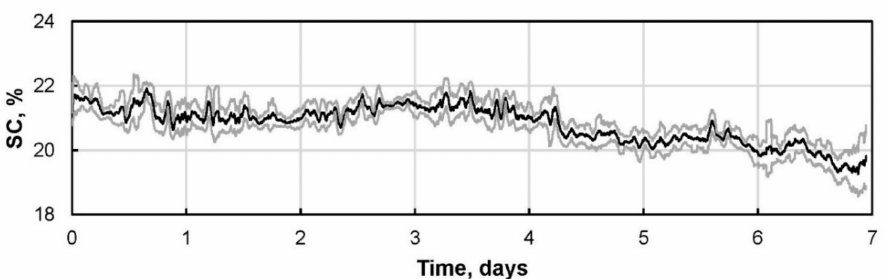
Figure 5. Estimated solids content (SC) shown by a black line, and standard deviations (SD) shown by the grey lines. Average SCs and SDs were estimated within one hour, using moving